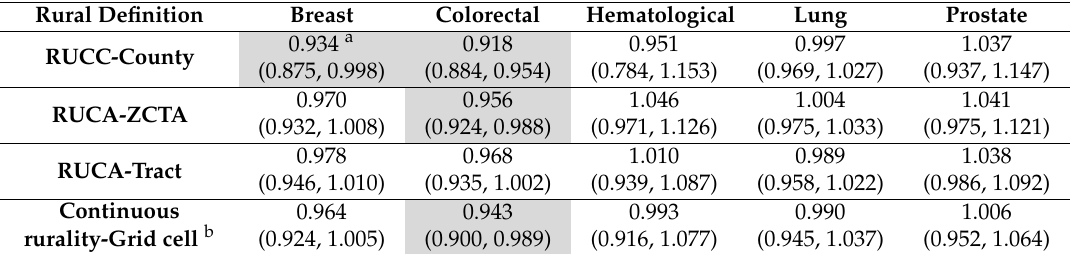
Table 4. Associations between multiple classifications of rurality and the late-stage cancer (Odds ratios and 95% confidence